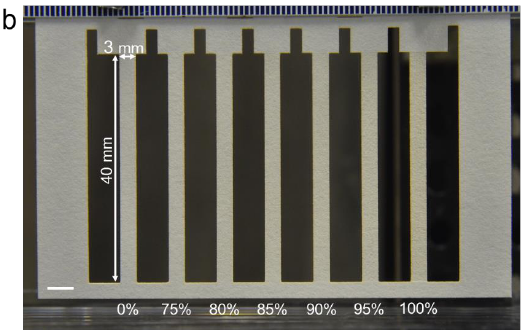
Figure 1. Wicking experimental setup. ( a ) Wicking was performed in a humidity-controlled chamber kept at 55% RH and 23 °C. DI H 2 O was wicked vertically in each channel to eliminate any